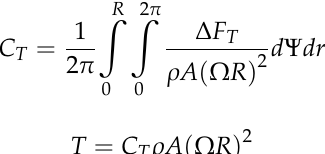
Figure 3. Model of a blade element.